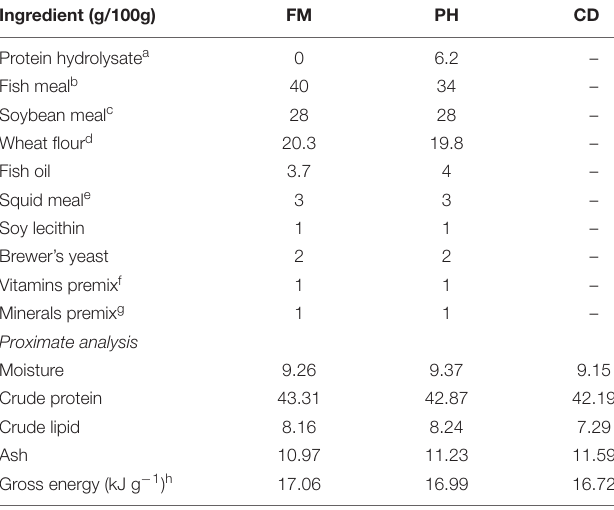
TABLE 1 | Analyzation of nutritional components of protein hydrolysate (g/100 g dry weight).